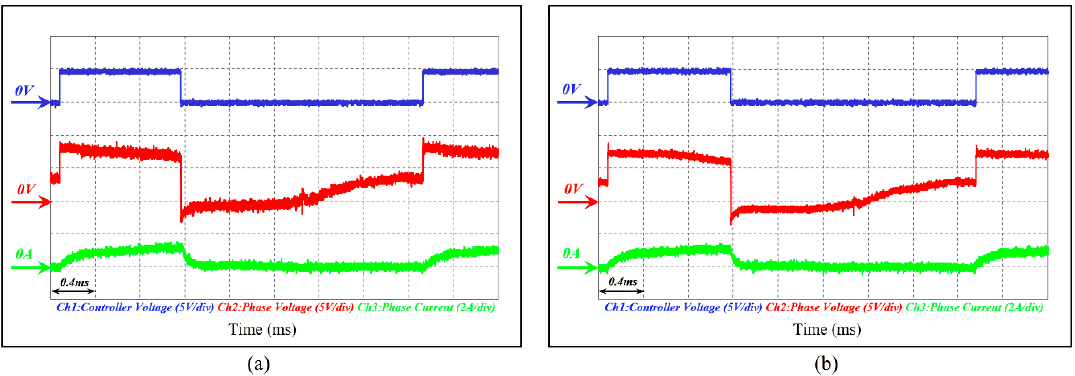
Figure 12. Voltage and current signals of ( a ) 35CS300 and ( b ) Somaloy 700 1P motors at a rotational speed of 9000 RPM.